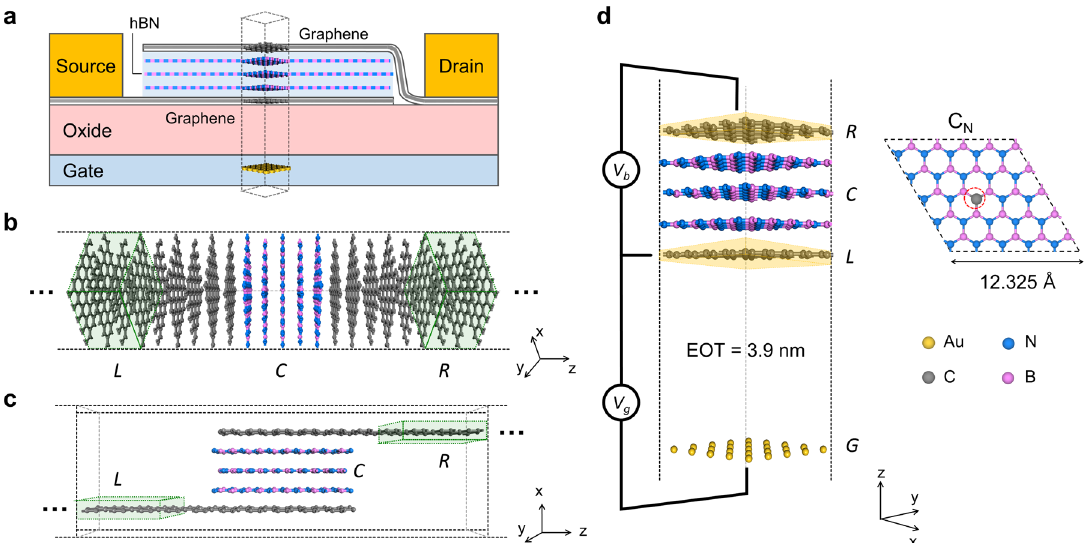
Fig. 1 Dif fi culties in ab initio modeling of graphene-based vertical FETs. a Schematic of the representative bottom gate graphene vertical FET device structure. b Graphite/hBN/graphite and c graphene/hBN nanoribbon/graphene junction models employed for DFT-NEGF calculations that require semi-in fi nite electrodes. Green shaded boxes indicate the electrode regions, for which within DFT-NEGF their matrix elements are replaced by those from separate bulk calculations. d The Au/vacuum/graphene/hBN/graphene vertical FET model employed in this work for MS-DFT calculations, which directly corresponds to the dashed box region in ( a ). Here, L, C, R, and G indicate the left electrode, channel, right electrode, and bottom gate electrode, respectively. Orange shaded boxes represent the electrode regions in MS-DFT calculations. A vacuum space between L and G was set to 10 Å, which corresponds to EOT of 3.9